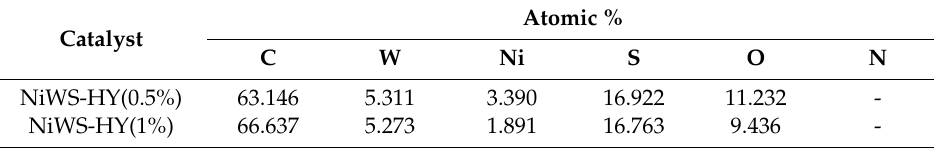
Table 5. Elemental composition of the catalyst surface according to XPS data.